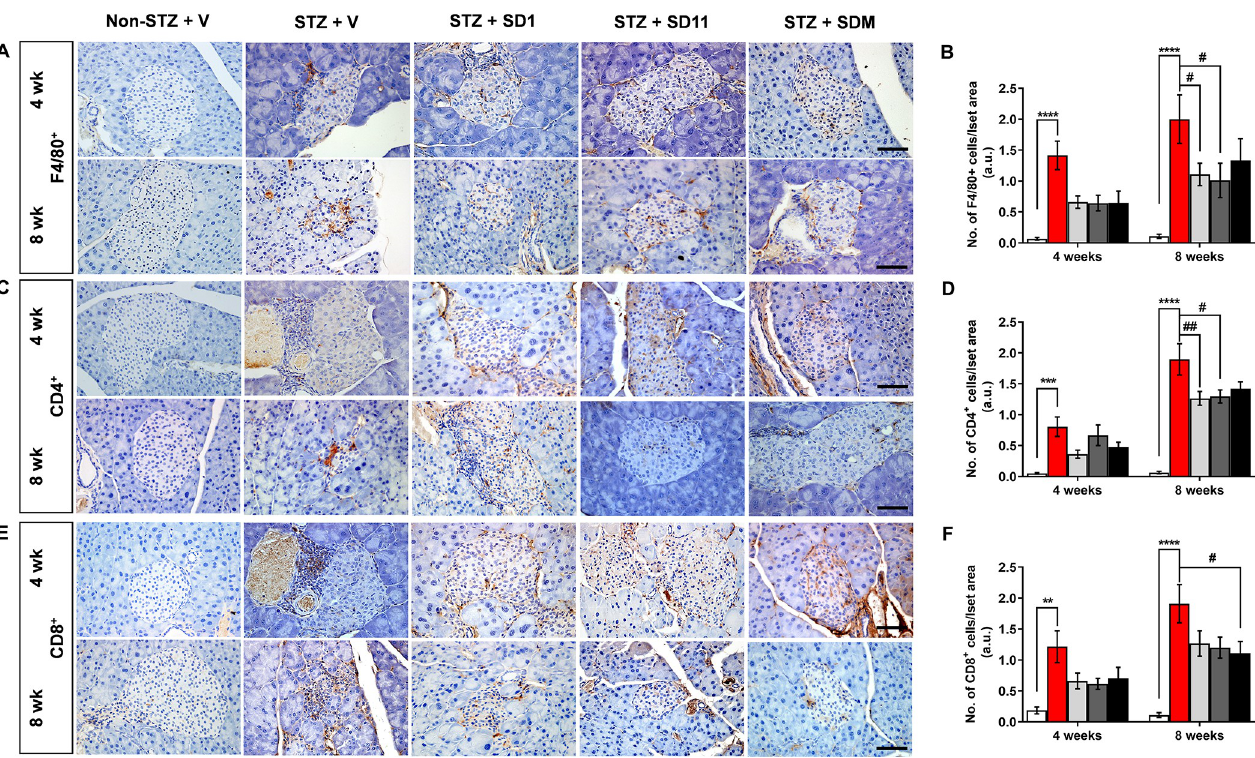
Fig 3. Probiotics attenuate intraislet immune cell infiltration in STZ-treated mice. Representative images and quantification of pancreas sections immunostained for (A-B) the macrophage marker F4/80 + , the T-cell markers (C-D) CD4 + , and (E-F) CD8 + at the 4- and 8-week time points. All images were taken at 400 magnifications. Scale bars, 50 μ m. Values represent means ± SEM. A measurement of approximately 50 independent islets per group (10 islets per mouse pancreas were randomly chosen from 5 animals per group) were examined. **** P < 0.0001, *** P < 0.001, ** P < 0.01 vs. the corresponding non-STZ group; ## P < 0.01, # P < 0.05 vs. the corresponding vehicle-treated STZ group.